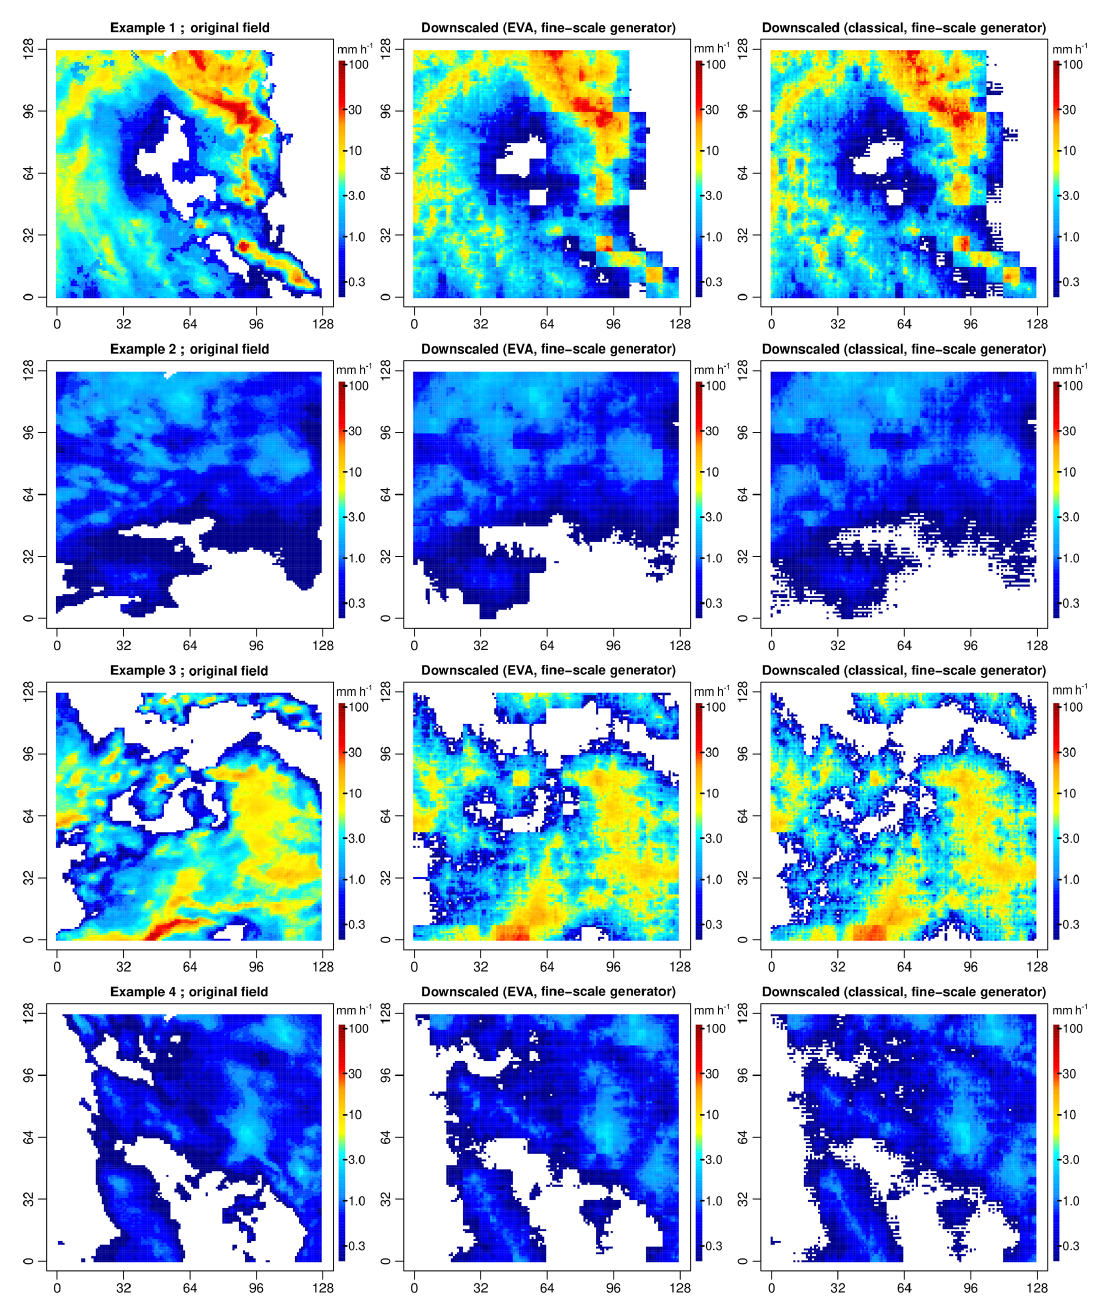
Figure 11. Downscaled rainfall fields for events 1–4 and a downscaling ratio of 64 (i.e., input resolution of 8km × 8km and target resolution of 1km × 1km). Similar format to Fig. 10 except that the generator model was derived from the 1km × 1km